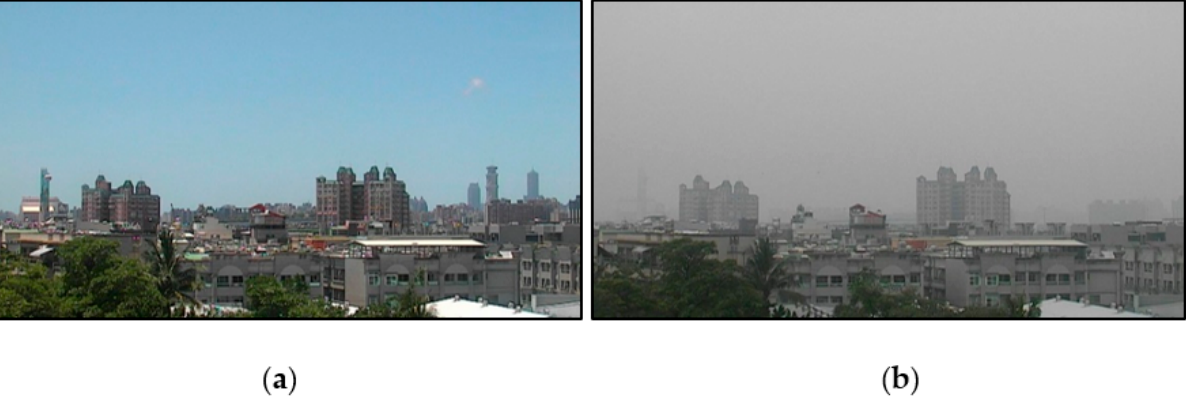
Figure 4. Images from the Renwu monitoring station in Kaohsiung, Taiwan; ( a ) low-AQI numerical image and ( b ) high-AQI numerical image.